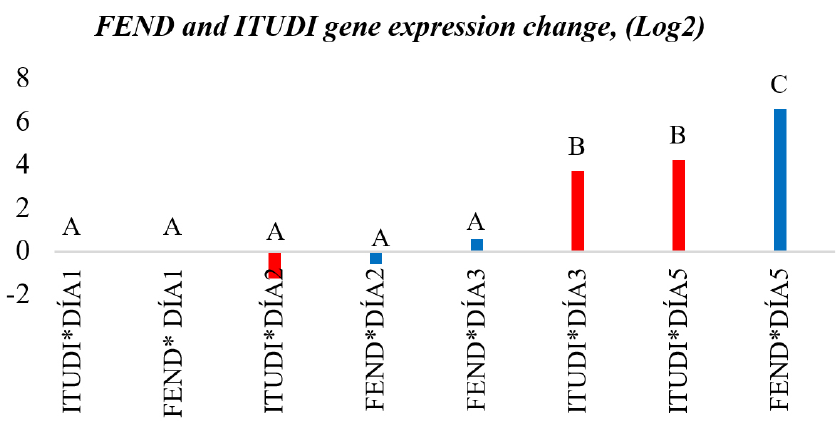
Fig. 5. Representation of relative gene expression change in logarithmic scale base 2 of FEND and ITUDI in Bacillus megaterium under fermentation.